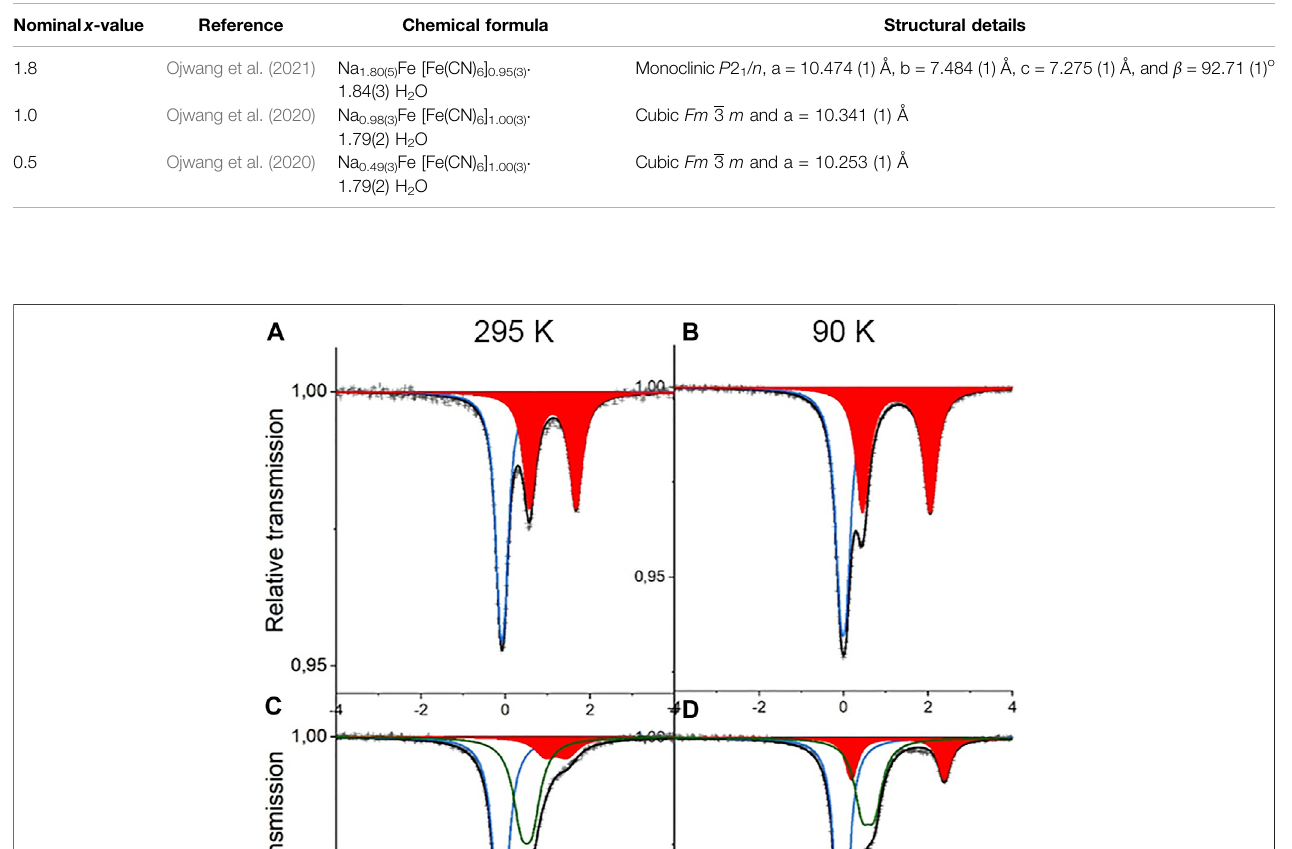
Frontiers in Energy Research |